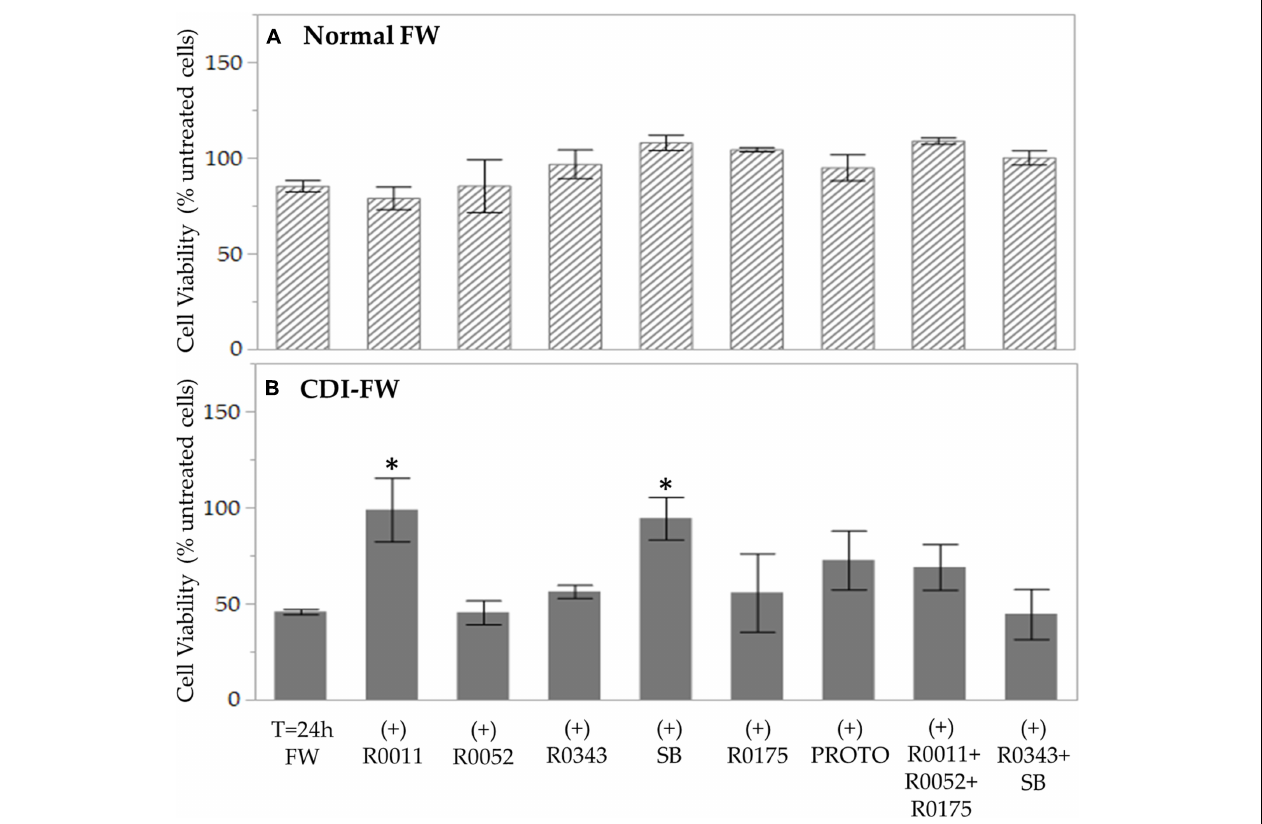
FIGURE 1 | Cell viability following the exposure of T84 cells to fecal water (FW) treatments as measured by the 3-(4,5-dimethylthiazol-2-yl)-2,5-diphenyltetrazolium bromide assay. (A) Cells treated with normal FW and (B) cells treated with Clostridioides difficile -infected (CDI) FW. Values are shown as mean ± SEM. The symbol ∗ represents significant differences between the means of treatments ( p < 0.05). R0011 = L. rhamnosus R0011; R0052 = L. helveticus R0052; R0343 = L. rhamnosus GG R0343; SB = S. boulardii CNCM I-1079; R0175 = B. longum R0175; PROTO = ProtecFlorTM; R0011 + R0052 + R0175 = combination of L. rhamnosus R0011, L. helveticus R0052 and B. longum R0175; R0343 + SB = combination of L. rhamnosus GG R0343 and S. boulardii CNCM